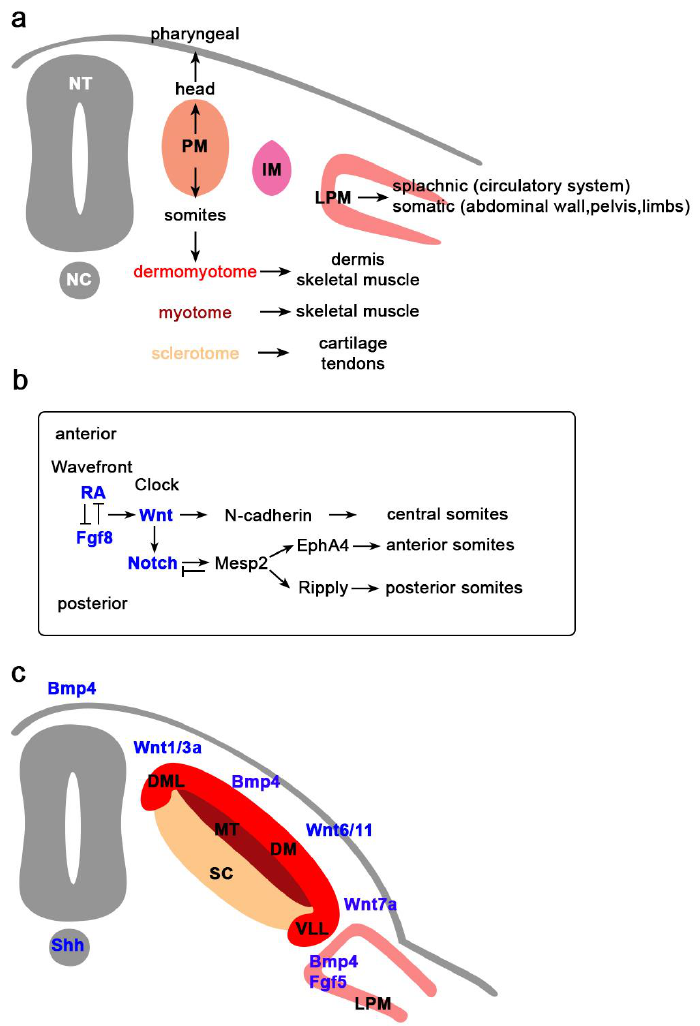
Figure 1. Signaling Molecules in Myogenesis ( a ) Paraxial mesoderm (PM) located next to the neural tube (NT). Dorsal PM gives rise to head and pharyngeal muscles while dorsal PM gives rise to somites. Intermediate mesoderm (IM) is located between the PM and the lateral plate mesoderm (LPM). LPM gives rise to the vascular system and skeletal muscles of the abdomen pelvis and some limb muscle. NC, notochord; ( b ) Anterior-posterior pattern of skeletal muscle is initiated by the RA/FGF8 inhibitory network, with AR promoting the anterior muscles and FGF8 the posterior. Activation of Wnt promotes the central somites and NOTCH signaling that will support formation of the anterior and posterior somites via EPH4 and RIPPLY, respectively; ( c ) Segmentation of somites into dermomyotome (DM), myotome (MT) and sclerotome (SC) is the result of signaling molecules secreted from the dorsal NT (BMP, WNT1/3a), notochord (SHH), ectoderm (WNT6/11, WNT7a, BMP4), and LPM (BMP4, FGF5). DML, dorsomedial lip; VLL, Ventrolateral lip.